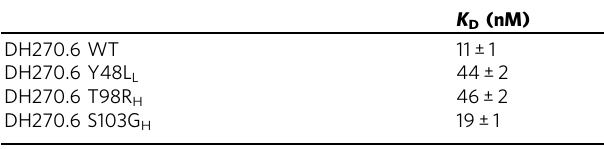
Table 2 Dissociation constants of Fab complexes with wild- type 92BR